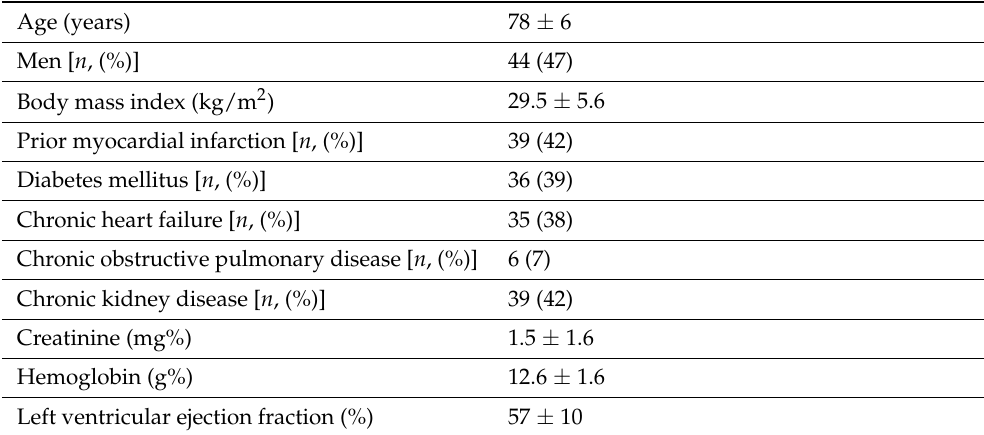
Table 1. Baseline characteristics of patients with severe aortic stenosis before the transcatheter aortic valve implantation procedure.